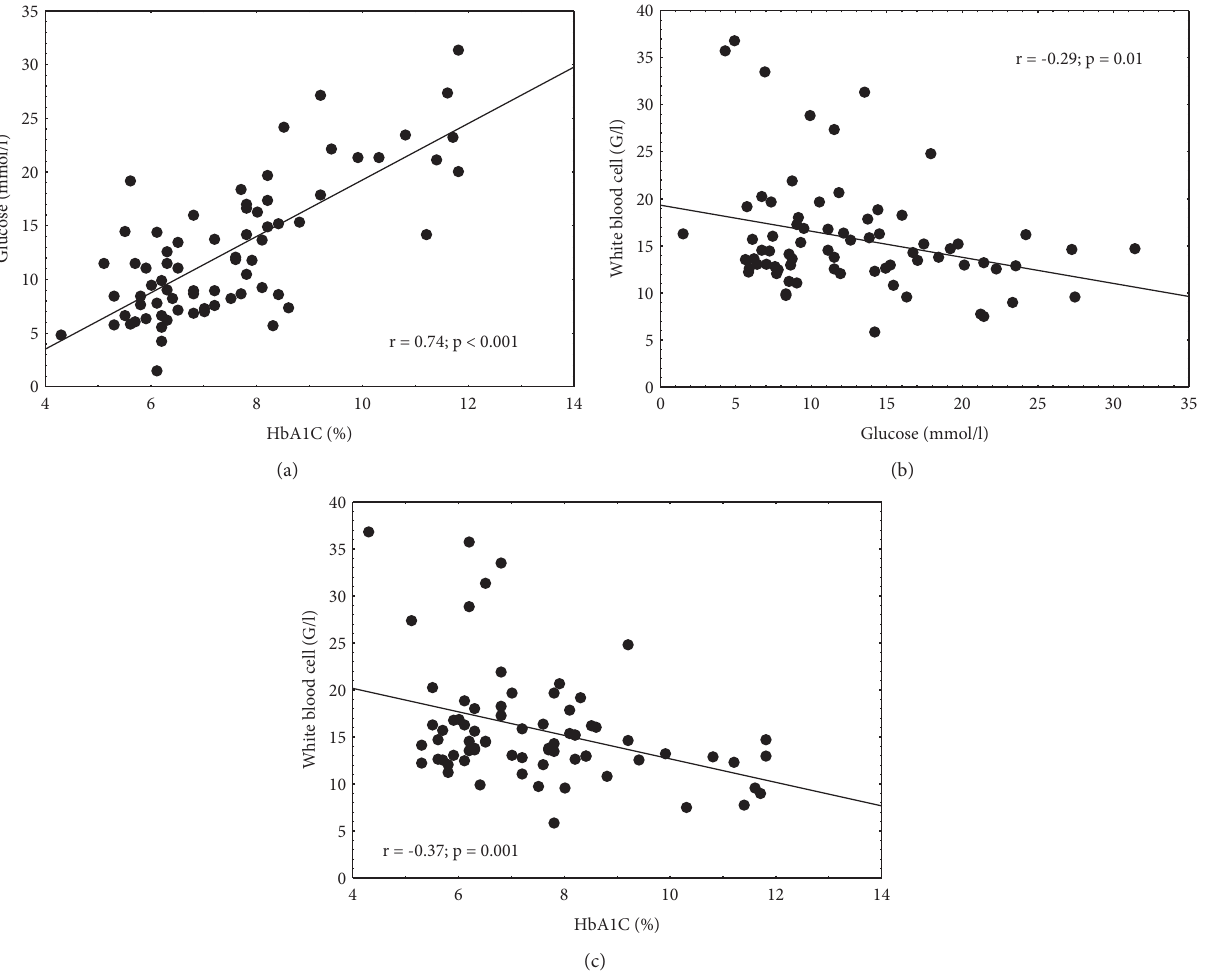
Figure 2: Correlations between glucose and HbA1C (%). (a) Glucose and white blood cell count. (b) White blood cell count and HbA1C (%) in diabetic, SIRS 24 h septic patients ( n �